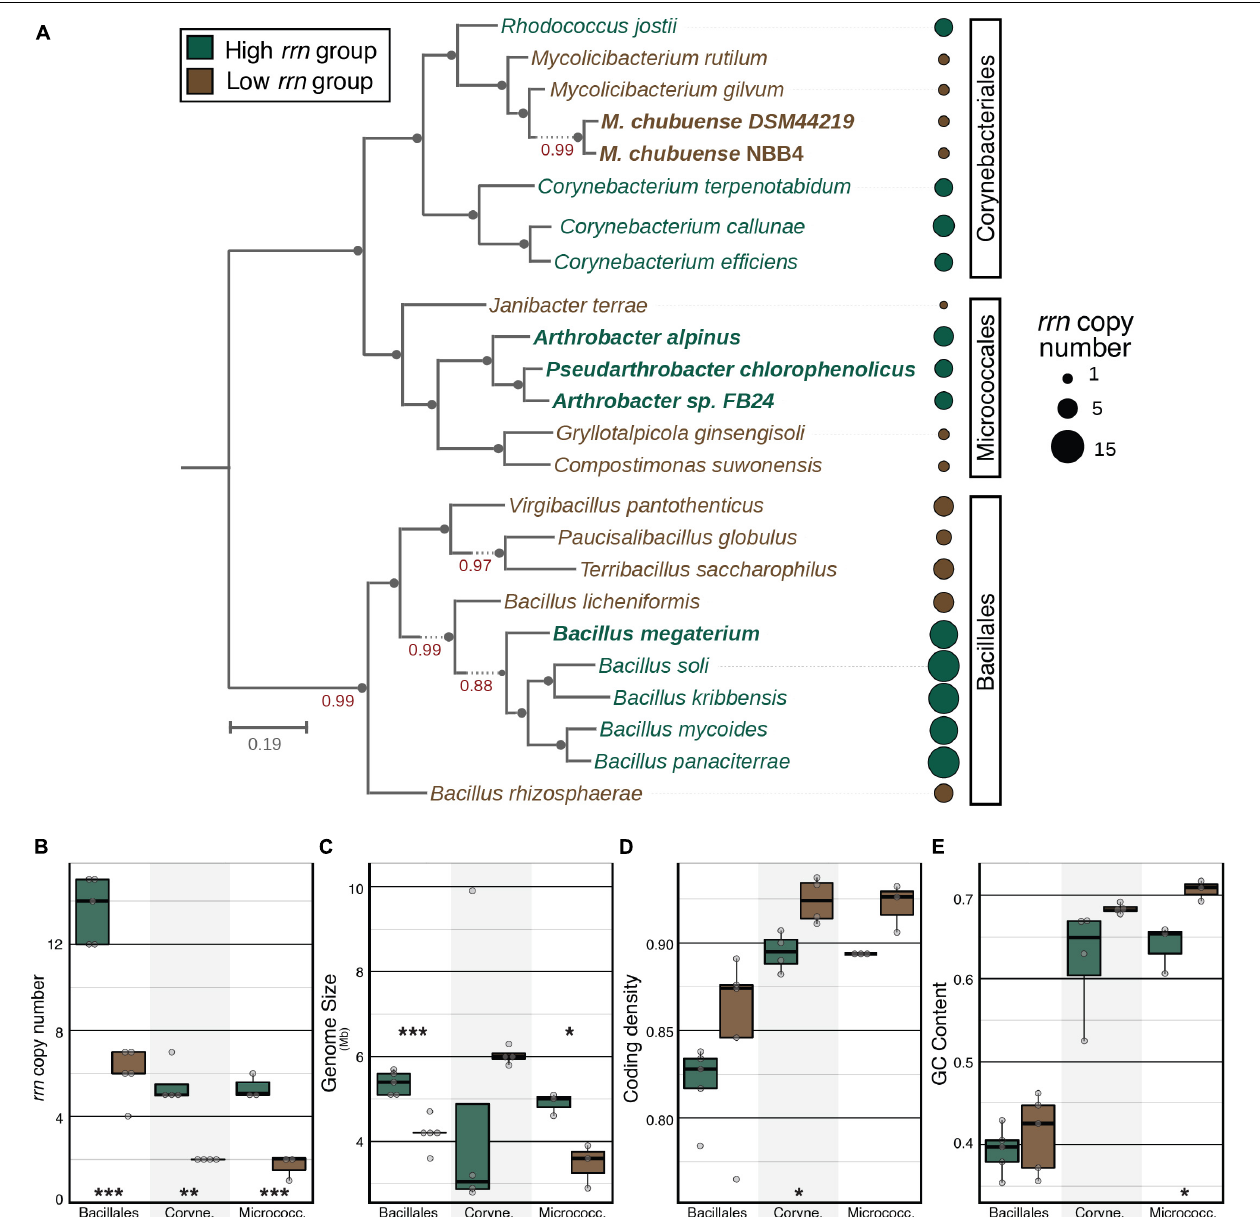
FIGURE 1 | Phylogenetic tree and genomic features of 24 isolates. Detailed information is summarized in Supplementary Table 1 . (A) A maximum-likelihood phylogenetic tree constructed from a multi-locus sequence alignment using “Insert Set of Genomes into Species Tree” in KBase. Bold isolates denote their genomes had 100% 16S rRNA similarity to an amplicon sequence variant detected in soil samples. For each phylogenetic order, tree leaves and annotation dots are colored based on order-specific rrn copy group. The size of each dot is scaled by absolute rrn copy number present in each genome. (B) Within each phylogenetic order, isolates from high vs. low rrn groups had significant differences in rrn copy number. High and low rrn copy groups also differed according to (C) genome size, (D) coding density, and (E) GC content. Asterisks denote statistically significant differences between high and low rrn copy groups within each phylogenetic order according to a Student’s t -test (* p ≤ 0.05, ** p ≤ 0.01, and *** p ≤